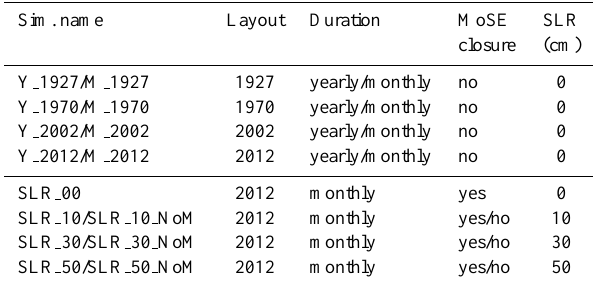
Table 2. Simulations description and set-up.